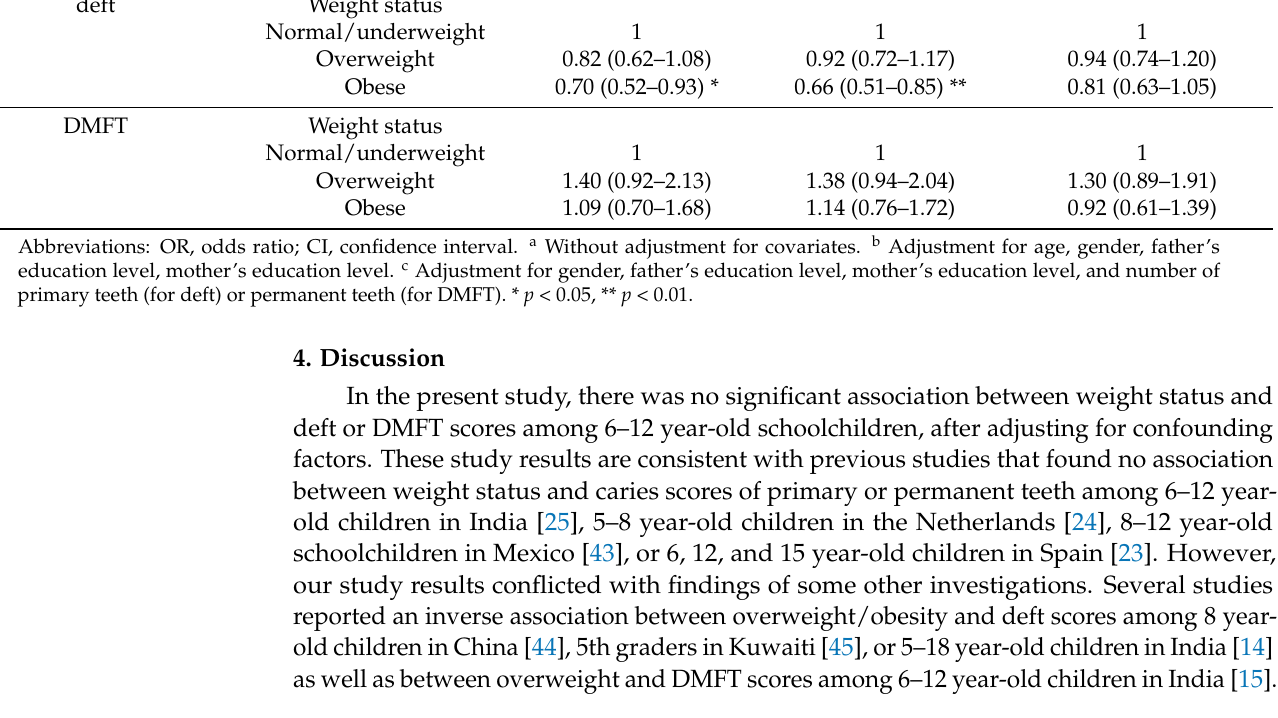
Table 5. The association between weight status and caries scores, results from the negative binomial regression analyses. Dependent Variable